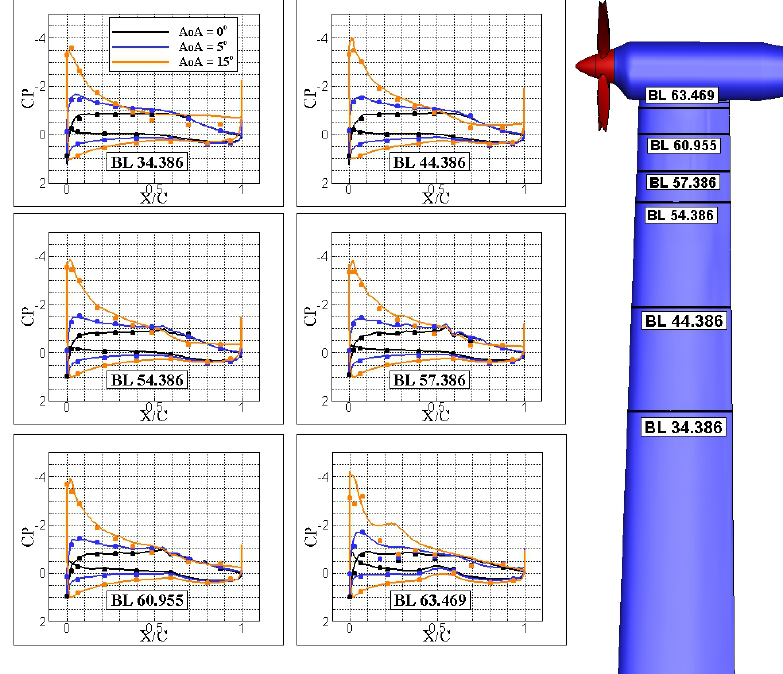
Figure 8. Surfaces pressure data of no-propeller predictions. Experiments are shown with circle markers. Lines correspond to Kestrel-predicted